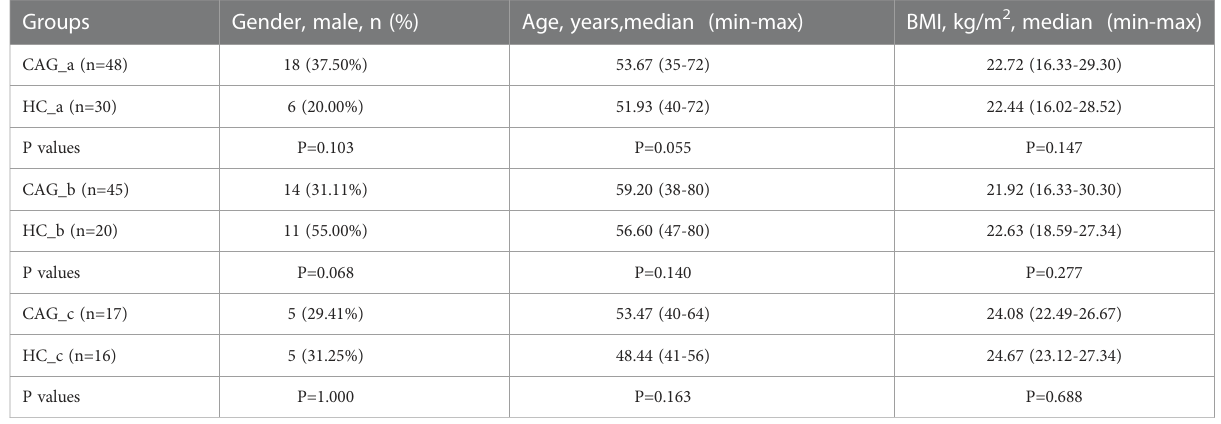
TABLE 1 The characteristics of the study population.